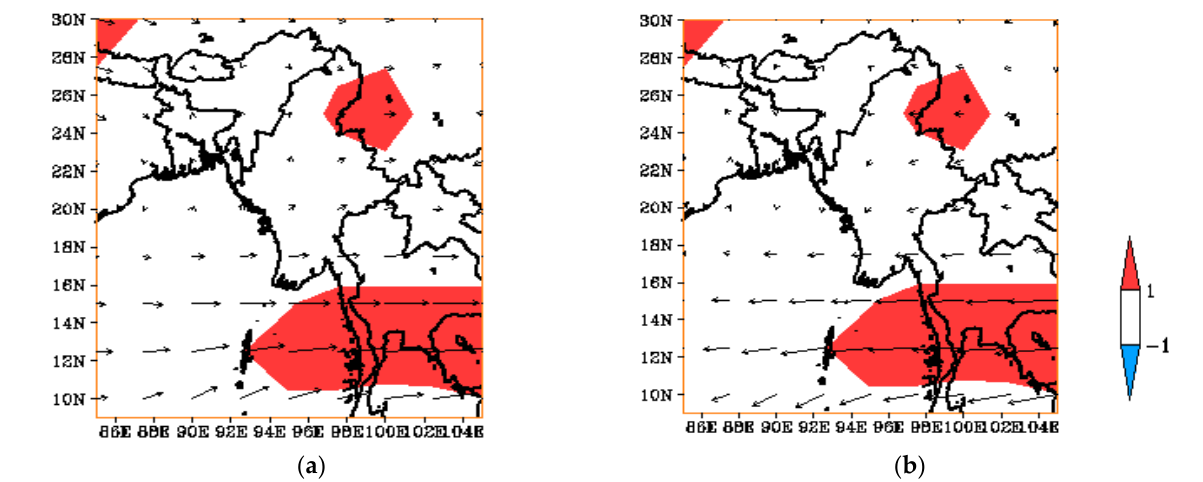
Figure 9. Rainy season (May ‒ October) wind anomaly at 850 hPa for ( a ) warm years and ( b ) cold years over Myanmar.